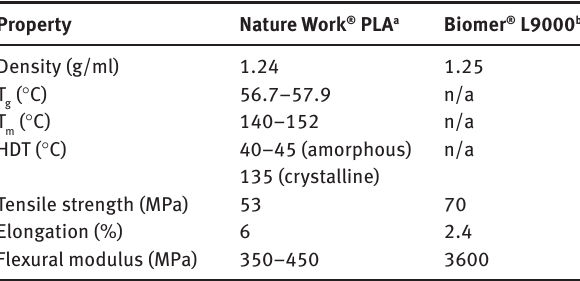
Table 1: Properties of